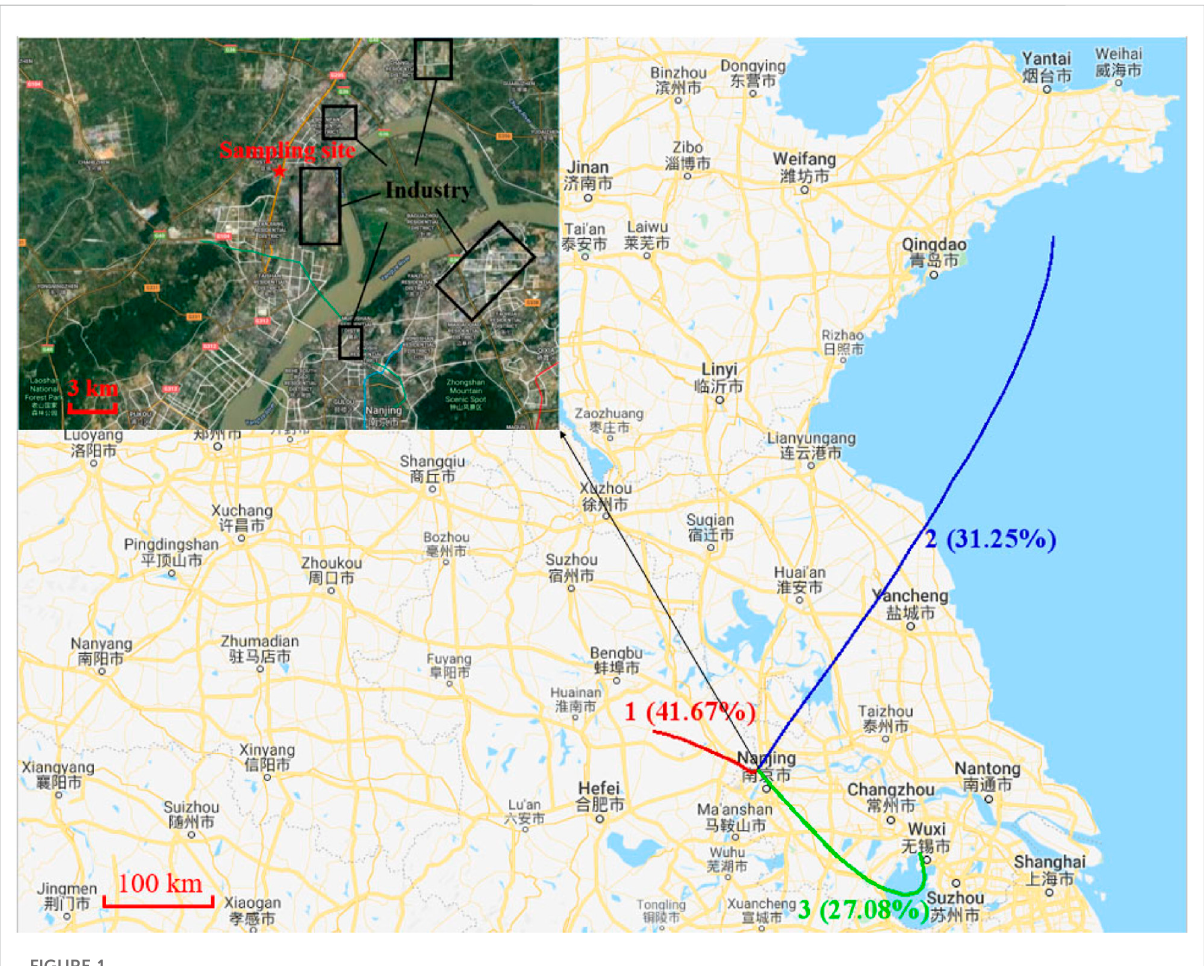
FIGURE 1 Measurement site and 24 h backward trajectory cluster at 500 m